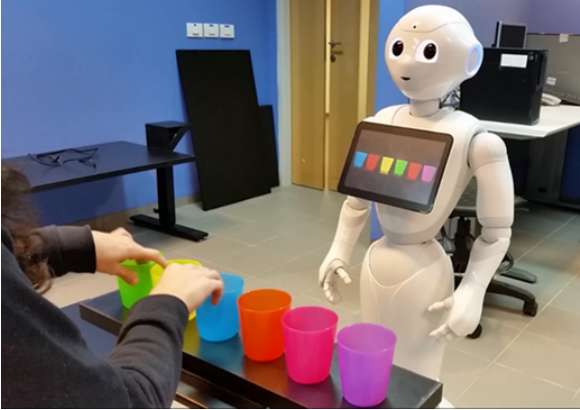
Figure 1: Experimental setup: The Pepper robot is showing a se- quence of colored cups on its tablet. The participant has to organize a set of actual physical cups on the table according to the displayed